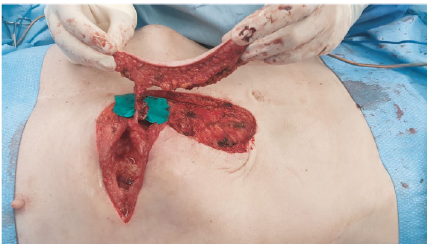
Figure 5: The superior epigastric artery perforator fl ap was harvested and the vascular pedicle (superior epigastric artery) skeletonized until the caudal margin of the 8 th rib to allow maximum freedom of movement and precise fl ap insetting.